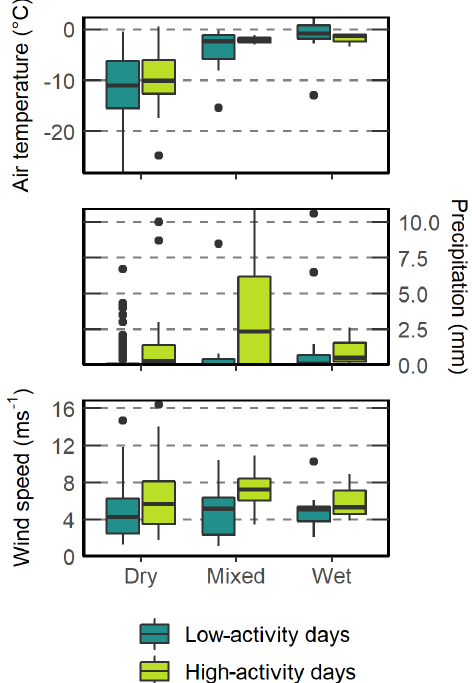
Figure 8. Boxplots showing the distributions for locally measured meteorological parameters by dry, mixed, and wet avalanche activ- ity classifications. Air temperature and wind speed are observed at the Gruvefjellet AWS, while precipitation is observed at the Sval- bard Airport